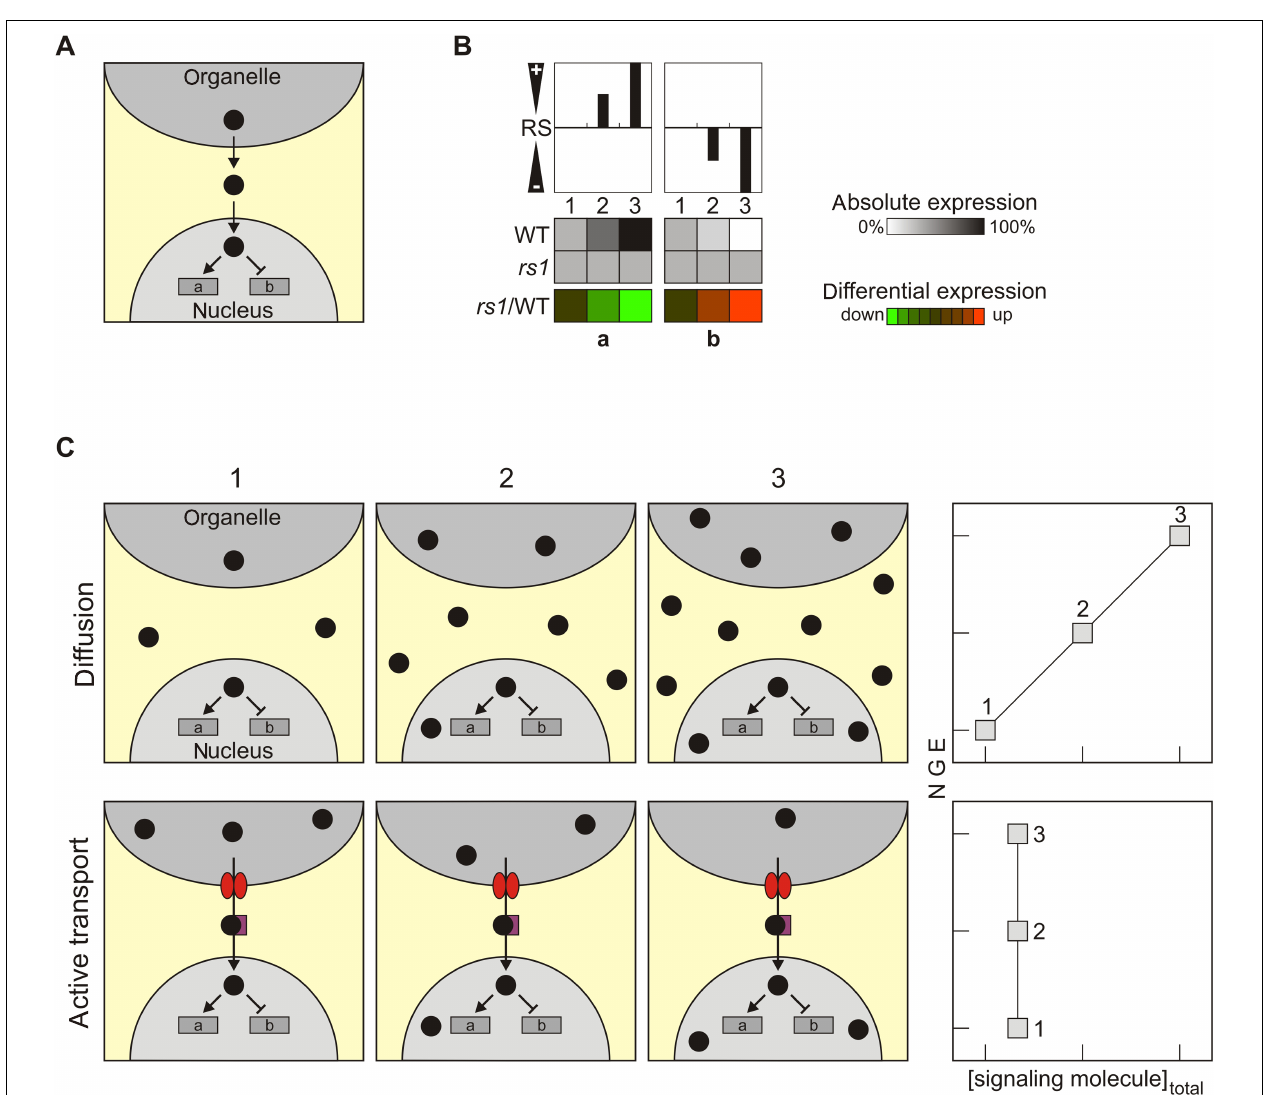
FIGURE 1 | Characteristics and transport of classical retrograde signals. (A) Schematic overview of the mode of operation of the simplest scenario for retrograde signaling, the case of a classical retrograde signal. (B) Overview of how changes in the relative abundance of the retrograde signal (RS) in the nucleus might affect NGE. Relative levels of the RS increase from state 1 (0%), state 2 (50%) to state 3 (100%), resulting in either induction (gene a) or repression (gene b) of the expression of a nuclear reporter gene (indicated in grayscale).The repressive effect of the RS is symbolized in the top panel by negative values (“ − ”), the inducing effect by positive values (“ + ”). In a signaling mutant rs , no expression changes occur and therefore differential expression ( rs1 /WT) in terms of down-regulation (gene a) or up-regulation (gene b) is observed (shown in color scale). (C) Passive diffusion versus active transport of RS. If the signaling molecule is disseminated by diffusion (upper panels, “Diffusion”), the total concentration of the signaling molecule in all